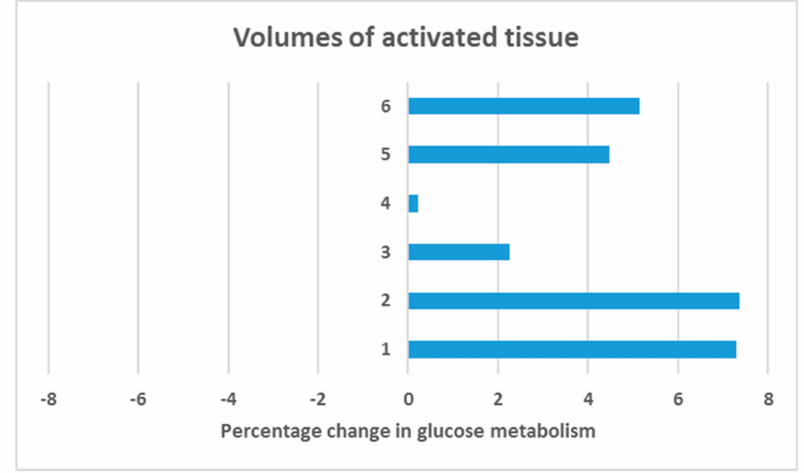
Figure 4. Volumes of interest analysis. We modelled volumes of activated tissue (VTA) based on the individually applied electric field per electrode, resulting in 6 VTAs for three subjects (VTA 1–2 = subject 1; VTA 3–4 = subject 2; VTA 5–6 = subject 3). Overall, a significant increase in glucose metabolism in VTAs of 4.4 % was observed when switching DBS ON compared to DBS OFF in a non-parametric Wilcoxon signed-rank test (Z = 2.201; SD = 2.6; p =